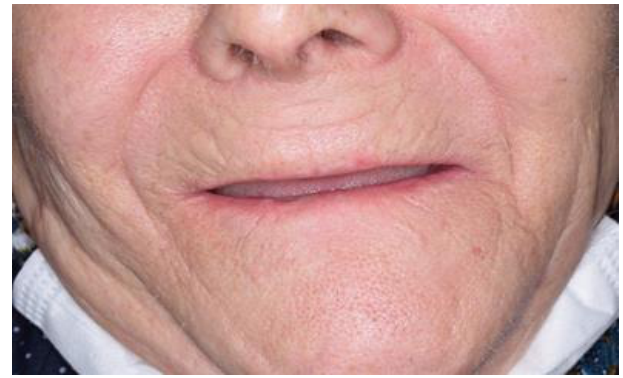
Fig. 2. Extraoral photograph of the patient before treatment.